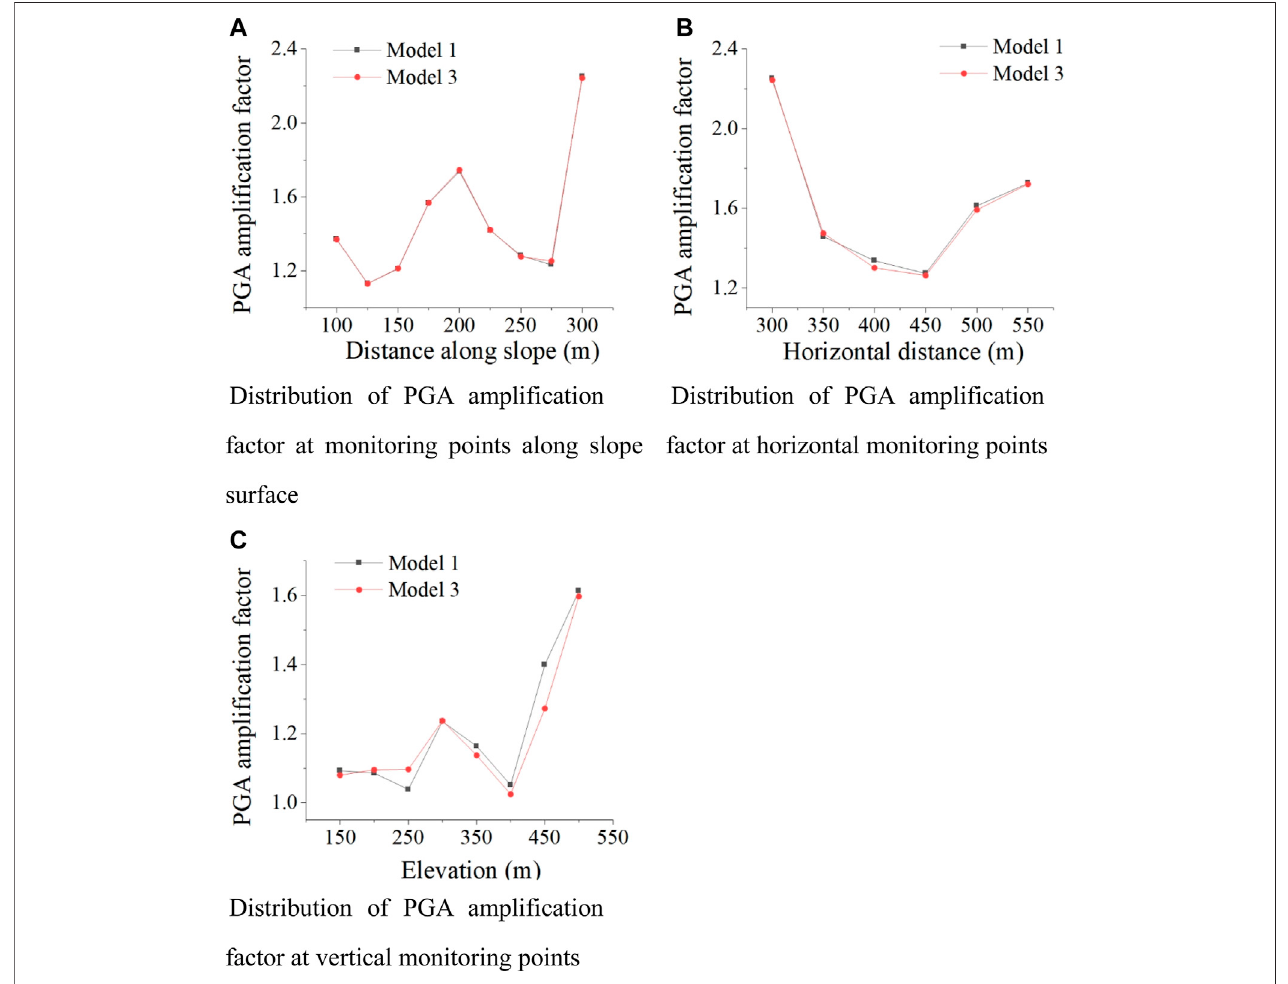
FIGURE 6 | PGA ampli fi cation factor of the monitoring points of slope. (A) Distribution of the PGA ampli fi cation factor at monitoring points along the slope surface. (B) Distribution of the PGA ampli fi cation factor at horizontal monitoring points. (C) Distribution of the PGA ampli fi cation factor at vertical monitoring points.